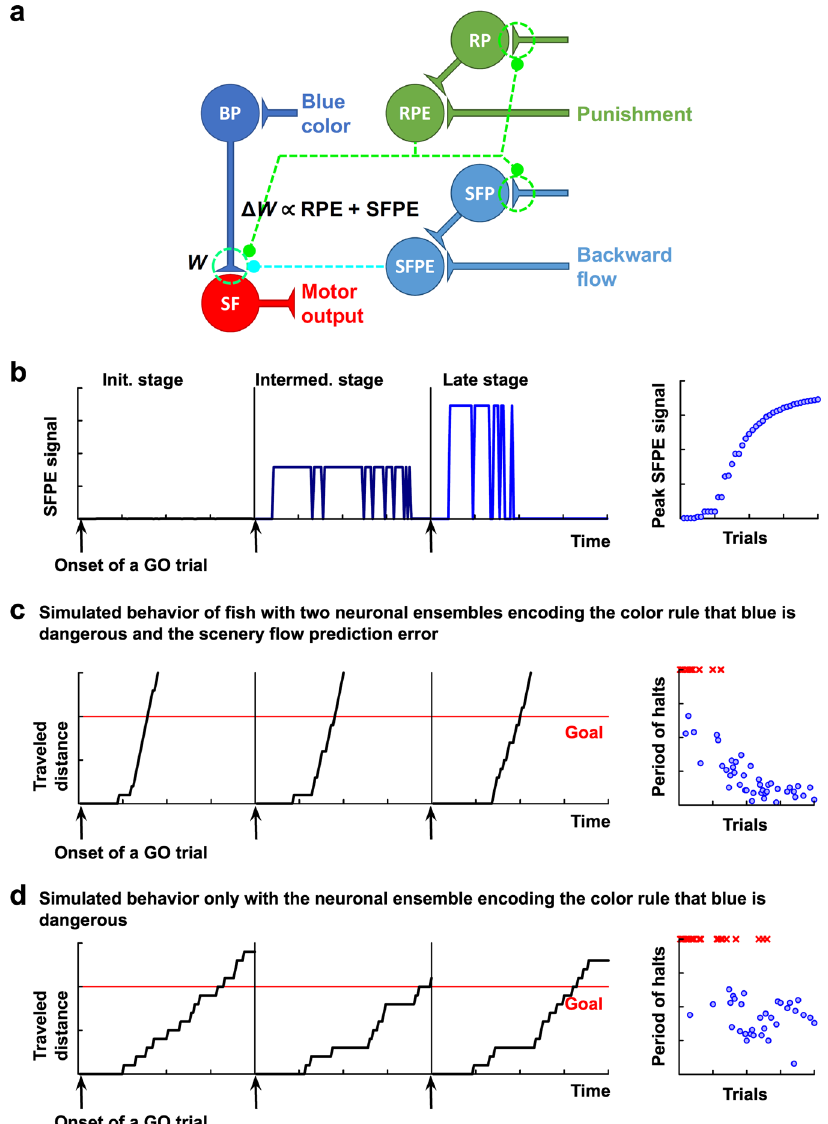
Fig. 8 Computational models replicate behavioral differences. a Schematic circuit diagram to select swimming forward. The neural network comprises ensembles encoding the perception of blue (BP, blue) and swimming forward (SF, red). Moreover, two additional units represent mutually different prediction errors. The reward prediction error (RPE, green) ensemble computes the difference between the (negative) reward prediction (RP) and actual punishment. Whereas, the scenery fl ow prediction error (SFPE, cyan) computes the difference between the scenery fl ow prediction (SFP) and actual backward fl ow. Here, the RPE ensemble took a positive value when the fi sh could avoid the punishment contrary to its expectation; otherwise, it took zero. The SFPE ensemble self-organized in the early stage of training to take a positive value when the fi sh sensed the SFPE at a given time point or take zero otherwise. The synaptic potentiation of W occurred only when the fi sh detected those errors, leading to minimization of those errors. b Emergence of the SFPE activity. Left: time-lapse activity changes in the three GO trials in the initial (left), intermediate (middle), and later (right) stages of training. Right: learning curve depicting the increase in activity of the SFPE ensemble. First 40 GO trials are shown. In the model, this increase occurred as a consequence of the emergence of an ensemble that encodes scenery fl ow prediction, because the SFPE ensemble is activated when the prediction exceeds the actual scenery fl ow sensation. c Behavior of synthetic fi sh in the presence of the RPE and SFPE-coding ensembles. Left: trajectories in the last three GO trials. The red line indicates the goal position. Right: the period of halts in GO trials over the training period. Because the fi sh sensed the SFPE whenever it stopped in the blue colored area, the SFPE signal potentiated the synapse more ef fi ciently than the RPE alone, leading to behavior involving reaching the goal with shorter halts. d Behavior of synthetic fi sh in the RPE-coding ensemble. Left: trajectories in the last three GO trials. The red line indicates the goal position. Right: the period of halts in GO trials over the training period. The blue circles and red crosses denote successful and failed GO trials,